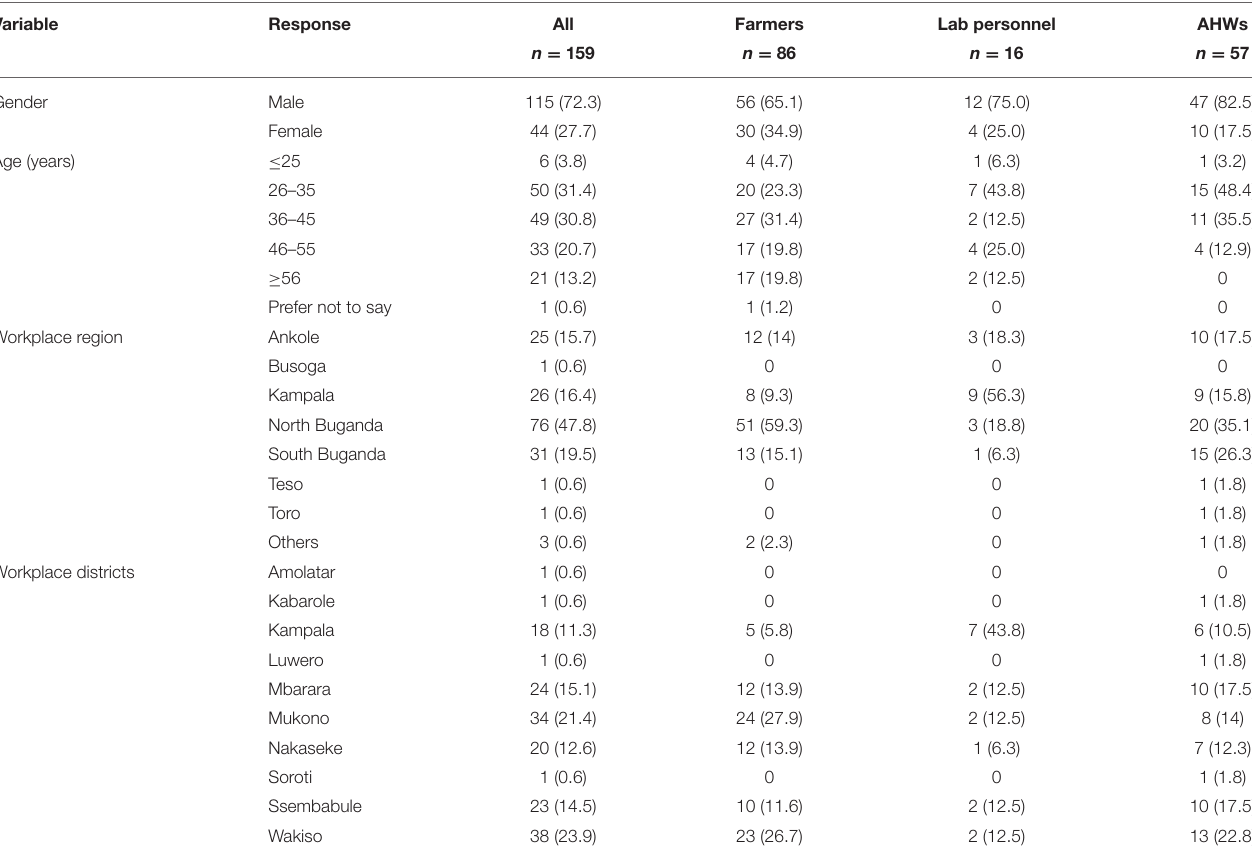
TABLE 1 | Demographic characteristics of respondents (farmers, laboratory technologists/technicians, and animal health workers).